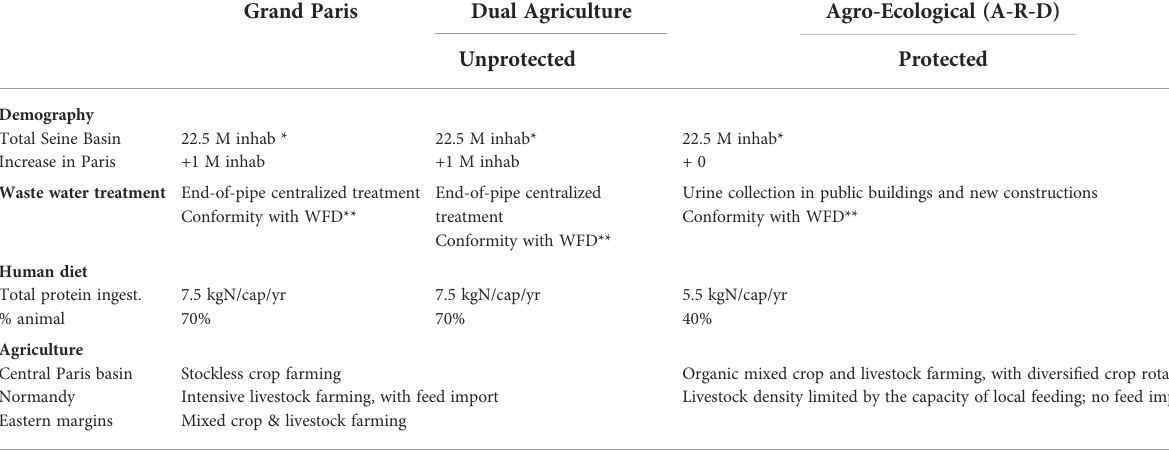
TABLE 1 Main features of the three proposed scenarios: Grand Paris, Dual Agriculture, and